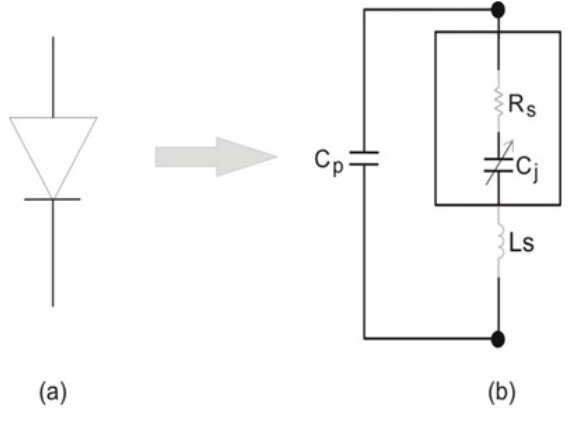
Figure 6: (a) SRD of AWR Microwave Office. (b) New model of a step recovery diode